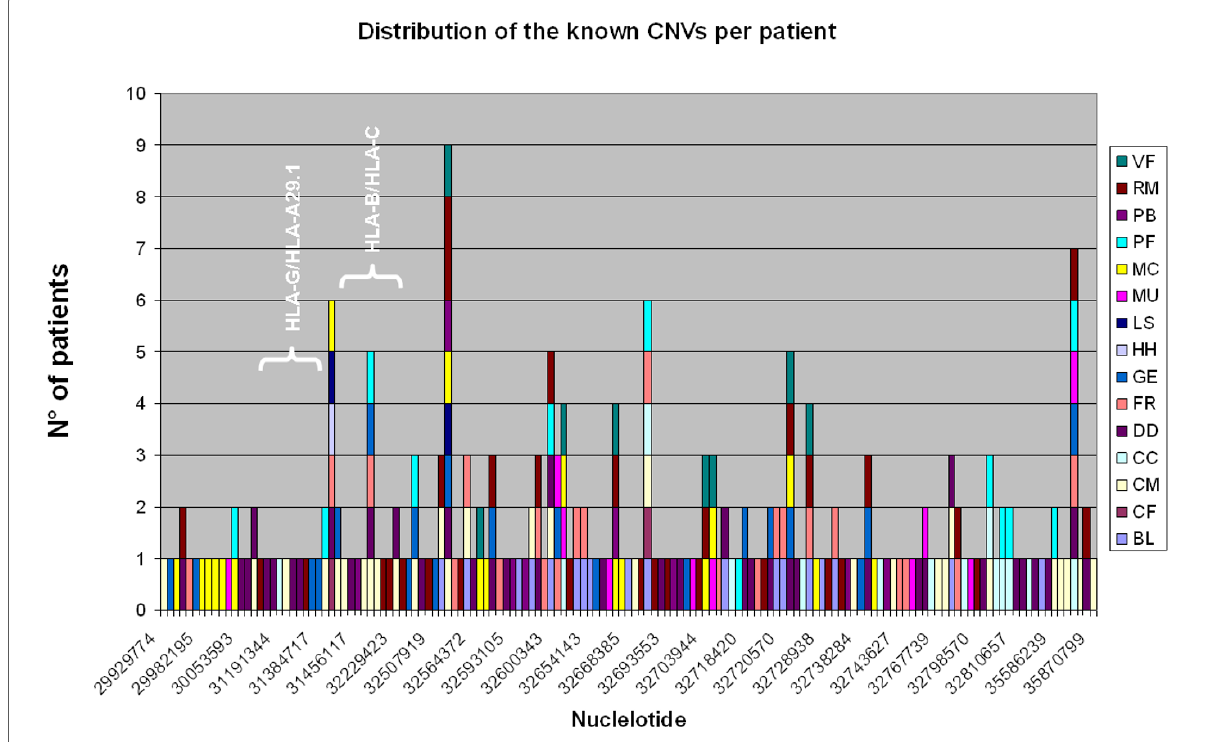
Figure 1 Genomic distribution of the known CNVs along the HLA locus among the patients studied . In the graph the starting nucleotide for each CNV is reported. The HLA gene regions are highlighted in